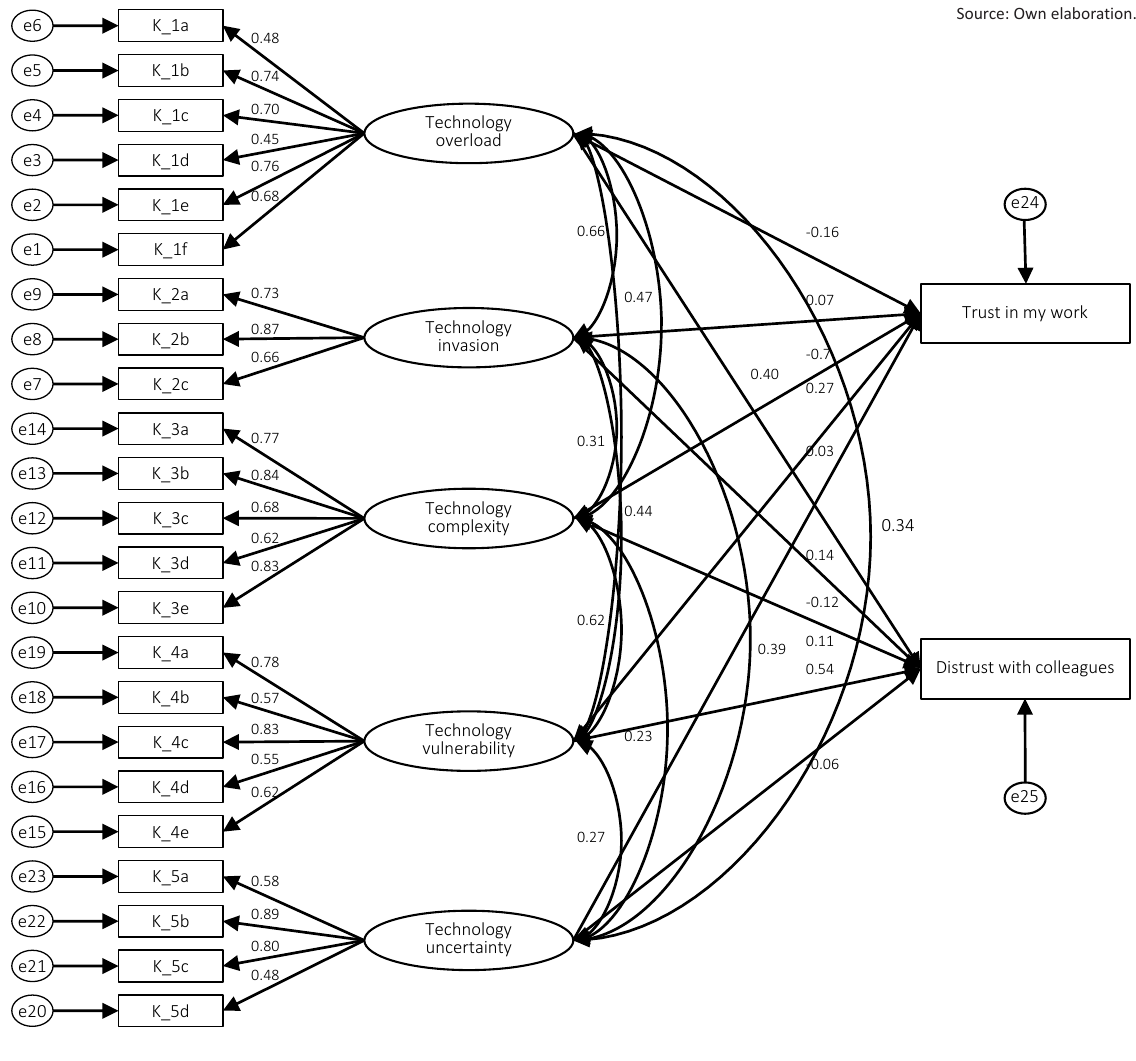
Figure 1. Technology stress and trust